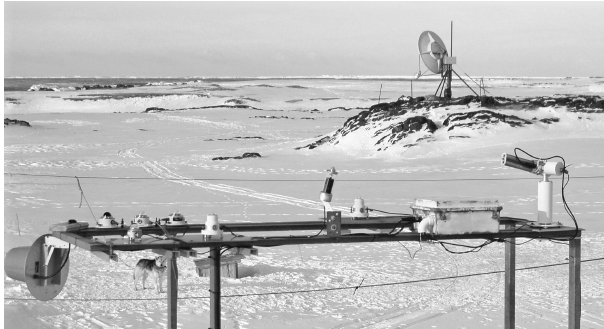
Figure 1. The observing platform at the Polish Polar Station Horn- sund (77 ◦ 00 (cid:48) N, 15 ◦ 33 (cid:48) E). Photo by P. S.